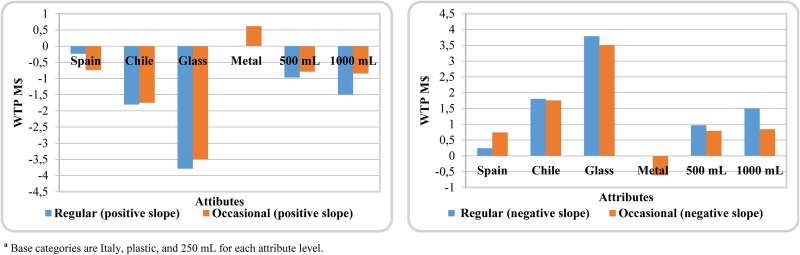
Willingness to pay (WTP) for positive and negative slope utilitya.